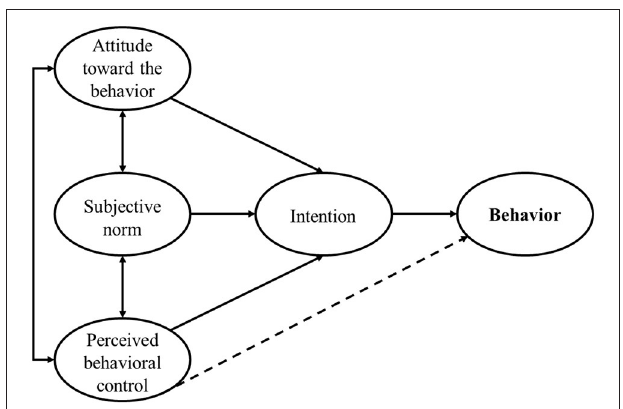
FIGURE 1 | Theory of planned behavior (TPB). Adapted from Ajzen